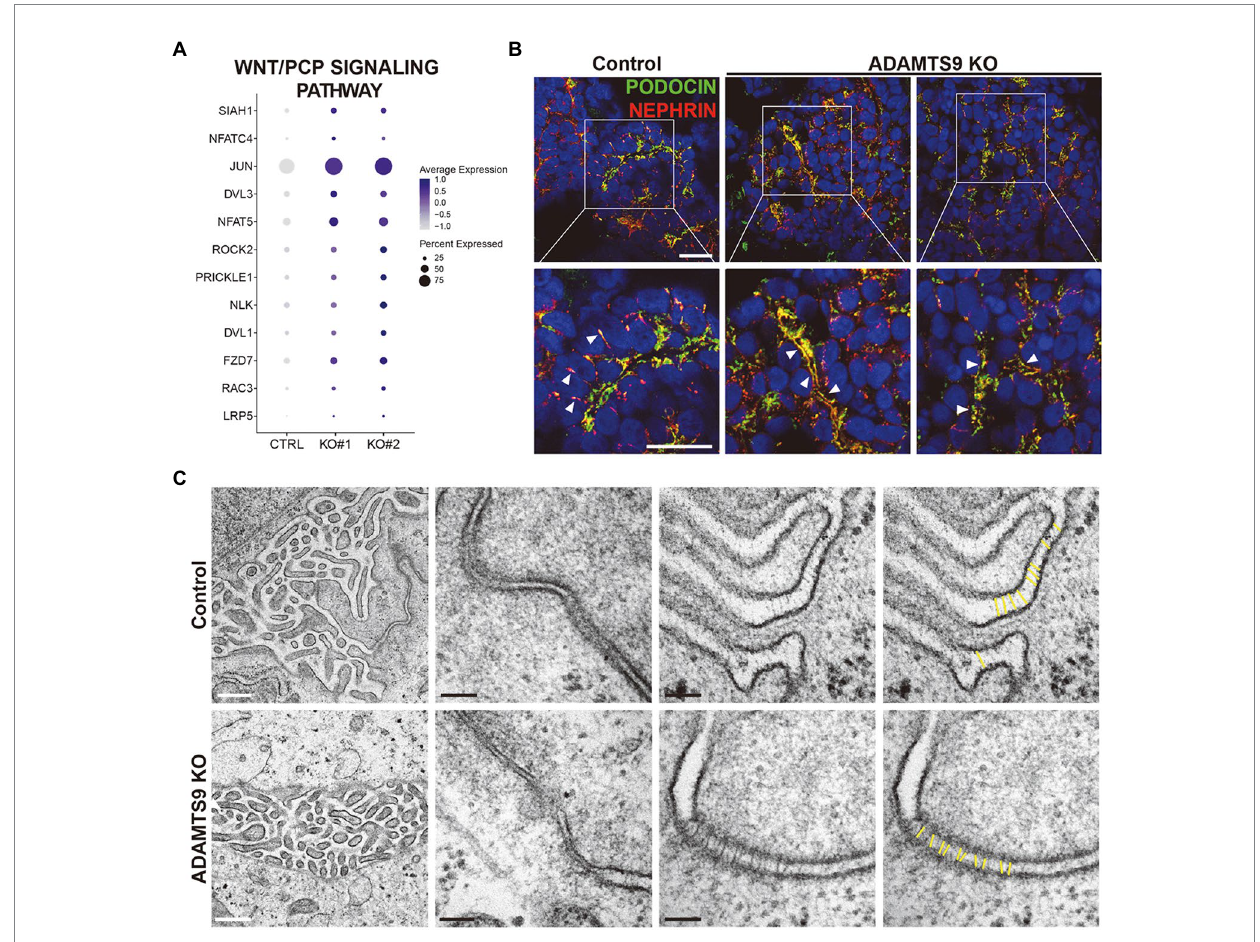
FIGURE 4 ADAMTS9 influences the Wnt/PCP pathway and regulates the localization of junction proteins. (A) Dot plot showing the expression of Wnt/PCP pathway genes in podocyte clusters across control and ADAMTS9 knockout (KO) organoids. (B) Immunostaining of kidney organoids showing NEPHRIN and PODOCIN localization in ADAMTS9 KO podocytes. White arrows indicate NEPHRIN and PODOCIN localization. White arrows indicate NEPHRIN and PODOCIN localization. NEPHRIN and PODOCIN were observed in the lateral side of podocytes in control organoids, but not in ADAMTS9 KO organoids. NEPHRIN and PODOCIN were localized only in the basal side of podocytes in ADAMTS9 KO organoids. Scale bars, 10 μ m. (C) Electron microscopy images of podocytes in kidney organoids. Ladder-like structures were observed in both control and ADAMTS9 KO podocytes. White scale bars, 500 nm. Black scale bars, 100